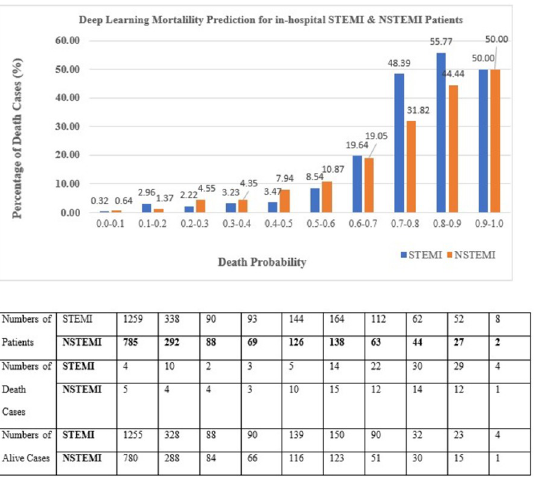
Fig 7. Breakdown of performance for DL (SVM selected var) in- hospital mortality prediction for both STEMI and NSTEMI patients.